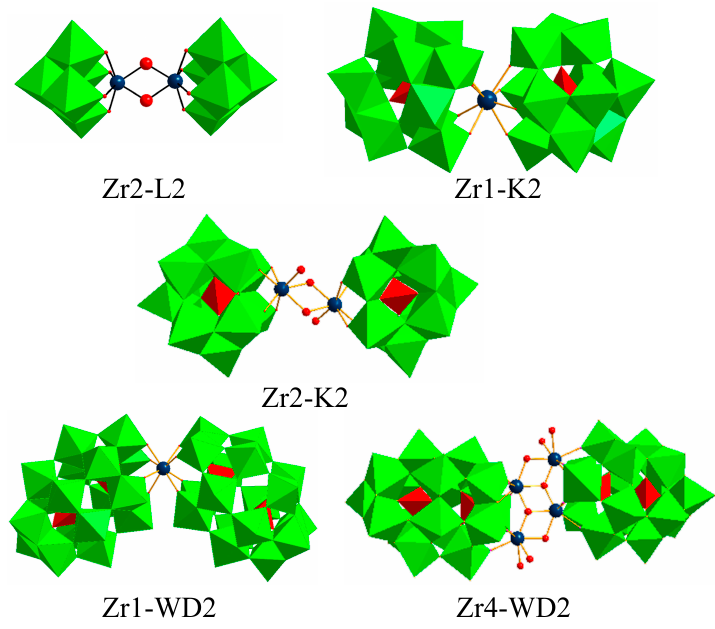
Figure 1. Combined polyhedral/ball-and-stick representations of Zr2-L2, Zr1-K2, Zr2-K2, Zr1-WD2, and Zr4-WD2. (Green octahedra: WO 6 , red tetrahedra: PO 4 , teal blue: Zr(IV) ion, red balls: oxygen